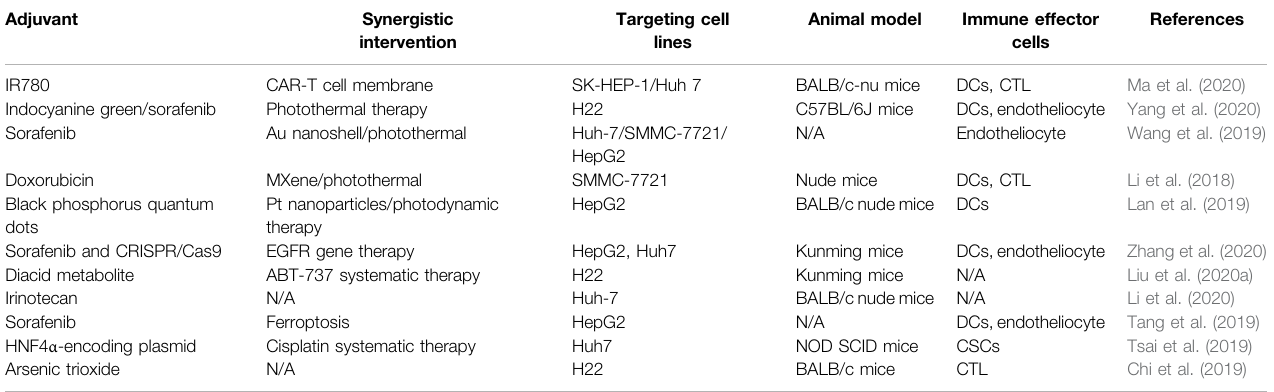
TABLE 1 | Summary and comparison of MSN-based immune related therapy for HCC. Adjuvant